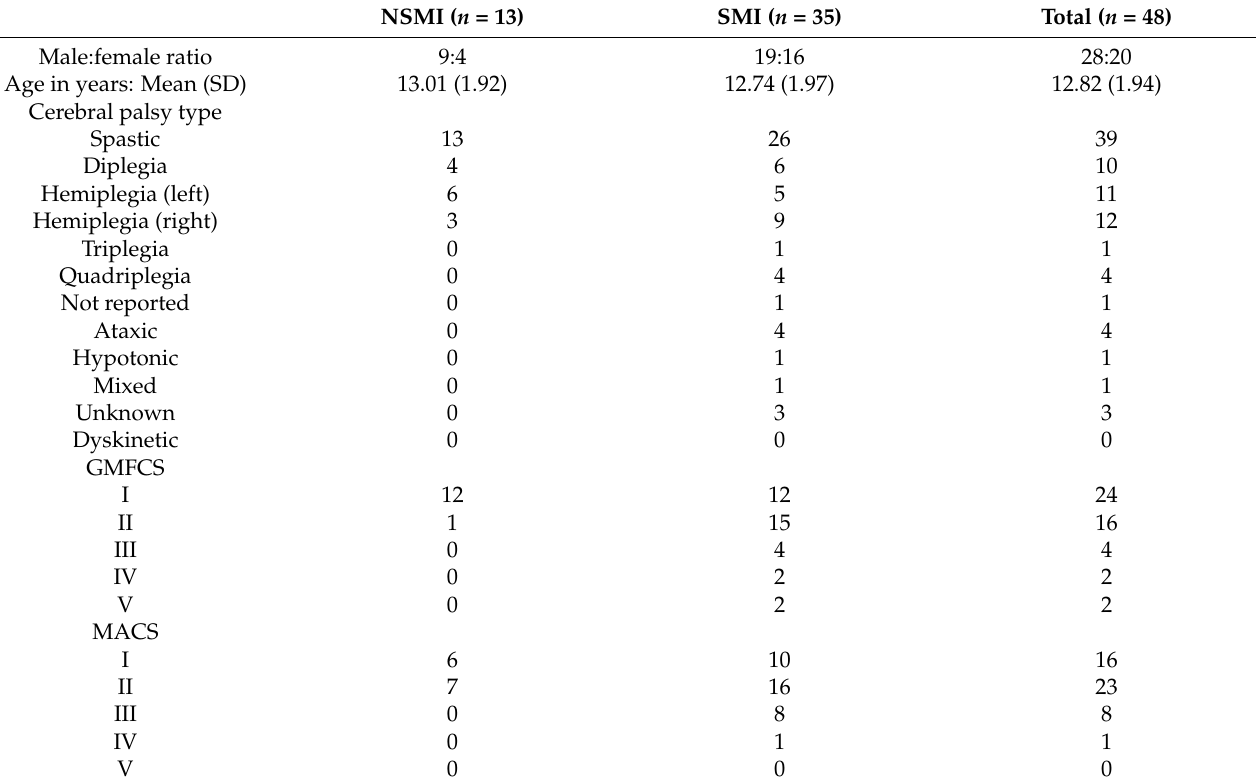
Table 1. Demographic characteristics of children with cerebral